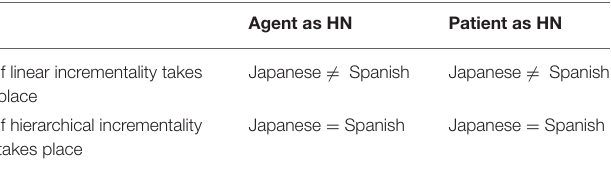
TABLE 1 | Summary of expected differences in order of gazes from 400ms. onwards, before name-related gazes start: Constant grammatical function and different word order across